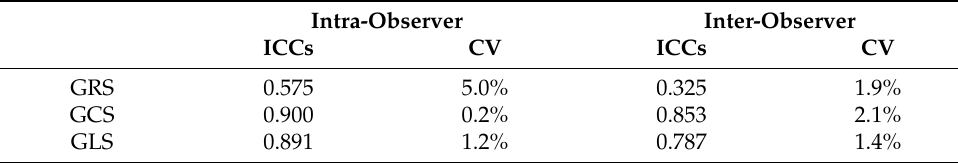
Table 6. The results of reproducibility in global myocardial